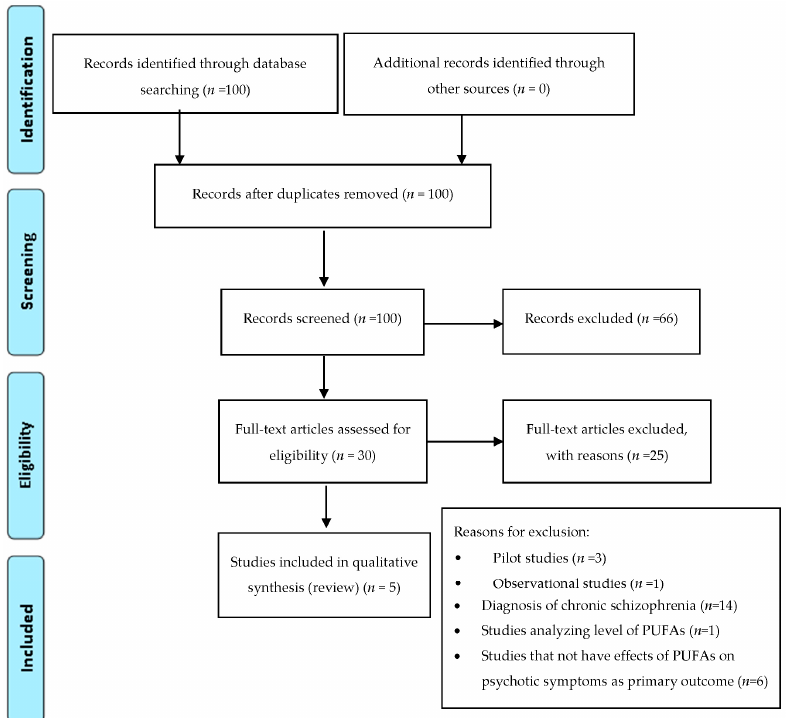
Figure 1. PRISMA diagram: ω -3 PUFAs supplementation in early psychotic symptoms. Int. J. Mol. Sci. 2017 , 17 , 2608